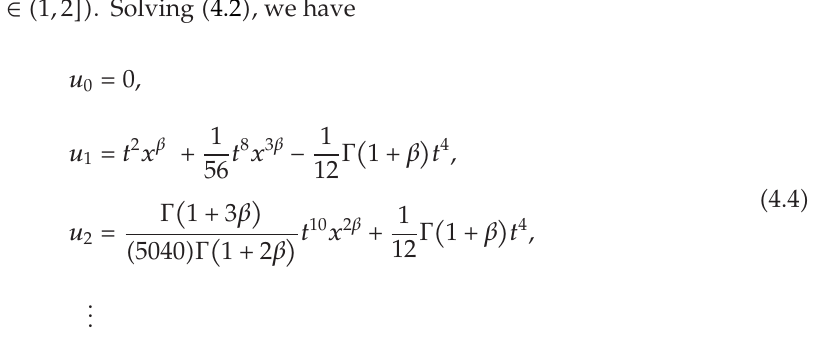
Figure 2 gives the comparison between the HPM 6th-order approximate solution of problem (cid:2) 4.1 (cid:3) in Case 2 with α (cid:9) 2, β (cid:9) 1 . 99, 1 . 95 , 1 . 90, and 1.85 and the solution of corresponding problem of integer order denoted by u 2 , 2 at t (cid:9) 0 .